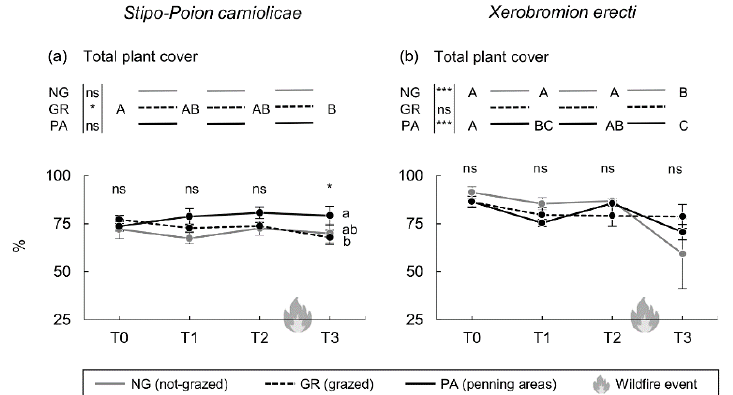
Figure 2. Results of the generalized linear mixed models performed on total plant cover in ( a ) Stipo-Poion carniolicae and ( b ) Xerobromion erecti grassland types. Uppercase letters indicate significant differences among years within each treatment while lowercase letters indicate significant differences among treatments within each year, according to Tukey’s post hoc tests. Years: T0, before grazing implementation; T1 and T2, after one and two years of grazing; T3, after the wildfire. Significance levels: ns, p ≥ 0.05; *, p < 0.05; ***, p < 0.001.